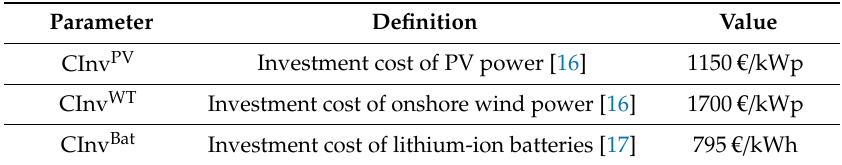
Table 11. Parameters related to investment